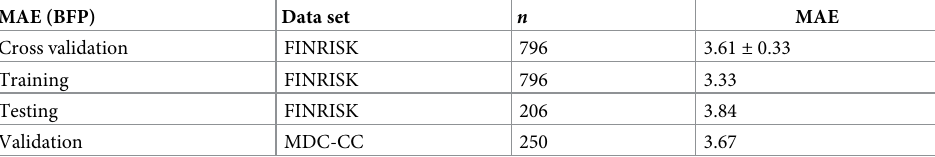
Table 1. Reproducibility of the model. Models were trained on the FINRISK training data set in a cross-validation loop, which results in a BFP cross validation MAE. Fitting the model on all the training data, using the best performing parameter set, results in a training MAE, testing the model on the hold out test data gives the testing error, and apply- ing the model to the independent MDC-CC data set results in the validation error. See S7 Table for results of all